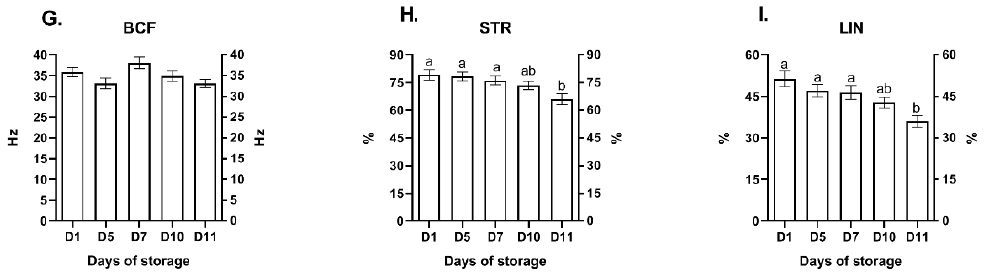
Figure 1. The effect of storage time (days) on motility variables of red deer epididymal sperm (mean ± SEM) stored in a liquid state at 5 °C. ( A ) TMOT, total motility. ( B ) PMOT, progressive motility. ( C ) VAP, velocity average path. ( D ) VSL, velocity straight line. ( E ) VCL, curvilinear velocity. ( F ) ALH, mean amplitude of lateral head displacement. ( G ) BCF, beat cross frequency. ( H ) STR, straightness. ( I ) LIN, linearity. Bars with different letters denote differences ( p < 0.05) between days of storage.